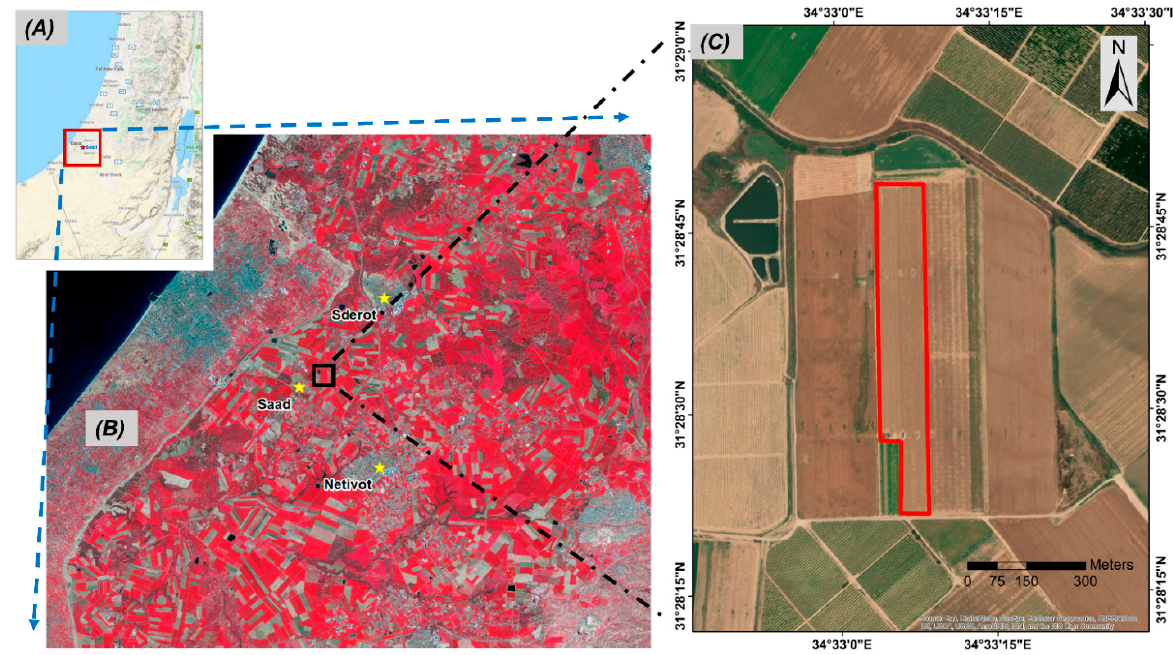
Figure 1. ( A ) Google terrain map of Israel; ( B ) Sentinel-2 false-color image covering part of Israel (RGB = bands 8, 4, 3) acquired on 25 July 2018. The black square represents the footprint of the image in C; ( C ) a blow-up of the research area near Saad (Source: ESRI base map). The experimental field is demarked in red.